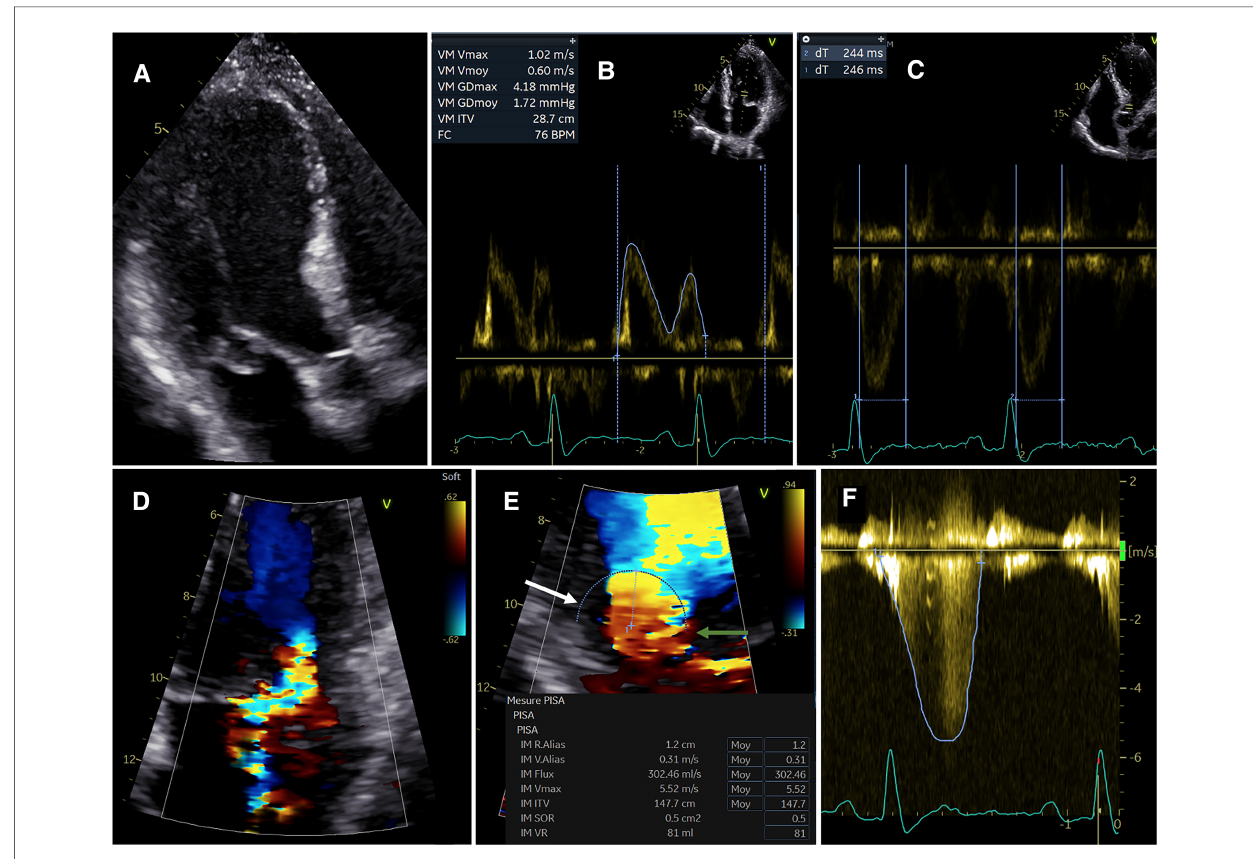
FIGURE 5 Echocardiographic assessment of MR severity grading. Illustrative example of a 50-year-old male patient with primary MR. Posterior MV fl ail lea fl et is seen on apical-3-chamber view ( A ). The mitral VTI is measured at 28.7 ( B : the sample volume is positioned at the tip of the mitral lea fl ets). The LVOT VTI is measured at 17.7 (see Figure 7 ), thus resulting in a high MAVIR (1.62). A short LV ejection time is observed (<260 ms, C ). The 3 components of the MR jet (proximal fl ow convergence, vena contracta and distal jet) are not clearly identi fi ed ( D ), therefore the 2D-VCW cannot be measured accurately. The PISA radius is measured at 1.2 cm for an aliasing velocity of 31 cm/s, thus suggesting signi fi cant MR. The MR EROA and MR RegVol estimated by the PISA method are of 0.51 cm2 and 81 ml, respectively. ( E ) However, the proximal fl ow convergence is partly constrained by the posterior LV wall (white arrow). Also there is a dropout of MR signal on the other side of the hemisphere (green arrow) because of a “ Doppler angle effect ” . Then, the MR is mainly mid-late systolic as shown by the CW Doppler MR signal ( F ). Hence, the MR RegVol by the PISA method is likely to over-estimate the true MR RegVol. All taken together, the MR is likely to be signi fi cant. CWD, Continuous-Wave Doppler; MAVIR, mitral-to-aortic velocity-time integral ratio; MV, mitral valve; VTI, velocity-time integral; TEE, transesophageal echocardiography; TTE, transthoracic